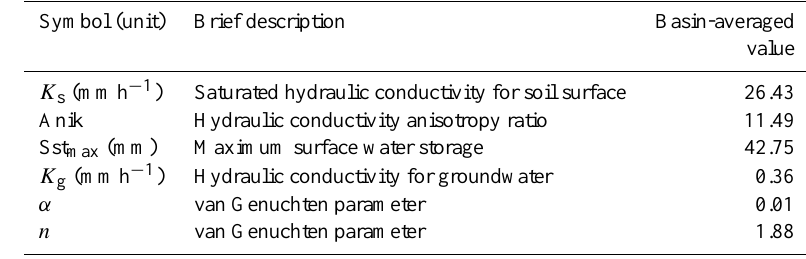
Table 2. WEB-DHM parameters.